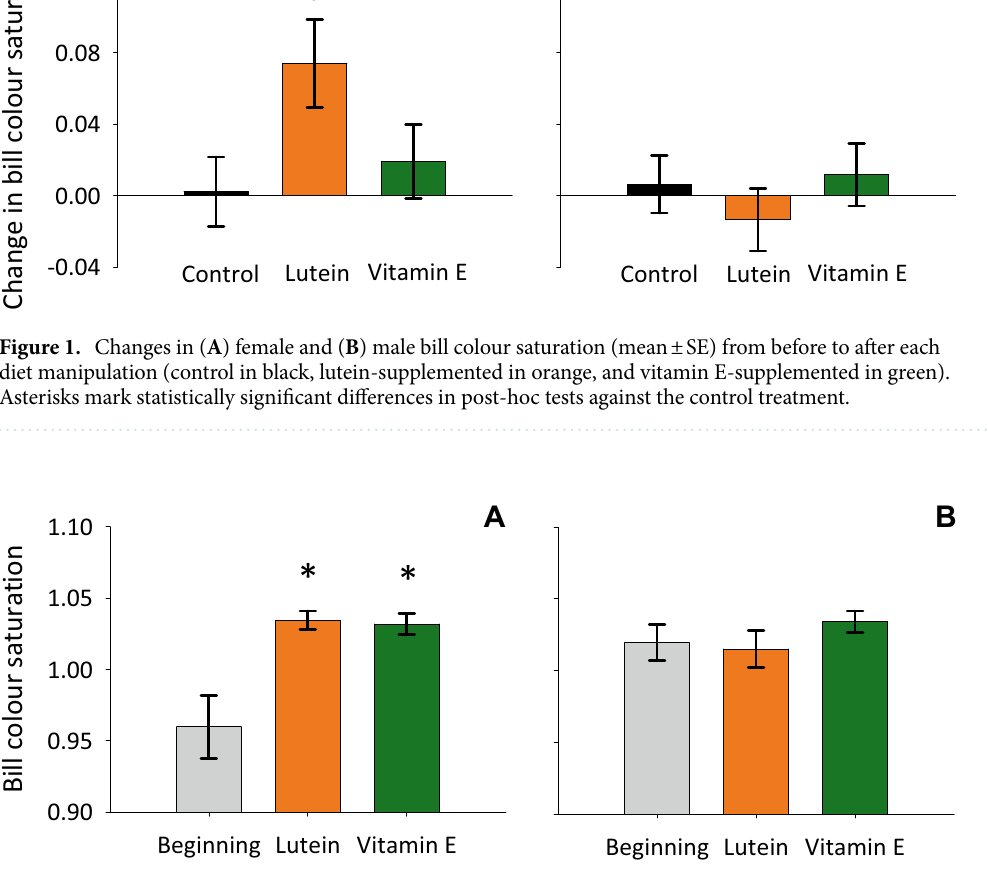
Figure 2. ( A ) Female and ( B ) male bill colour saturation (mean ± SE) before any diet manipulation (grey), and after each 4-week diet supplementation treatment (colours as in Fig. 1). Asterisks mark statistically significant differences between measurements after diet supplementation and measurements before any diet manipulation.